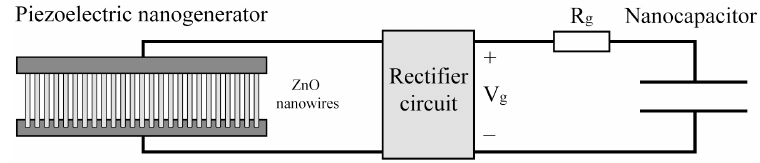
Figure 2. Piezoelectric powering nanosystem diagram.